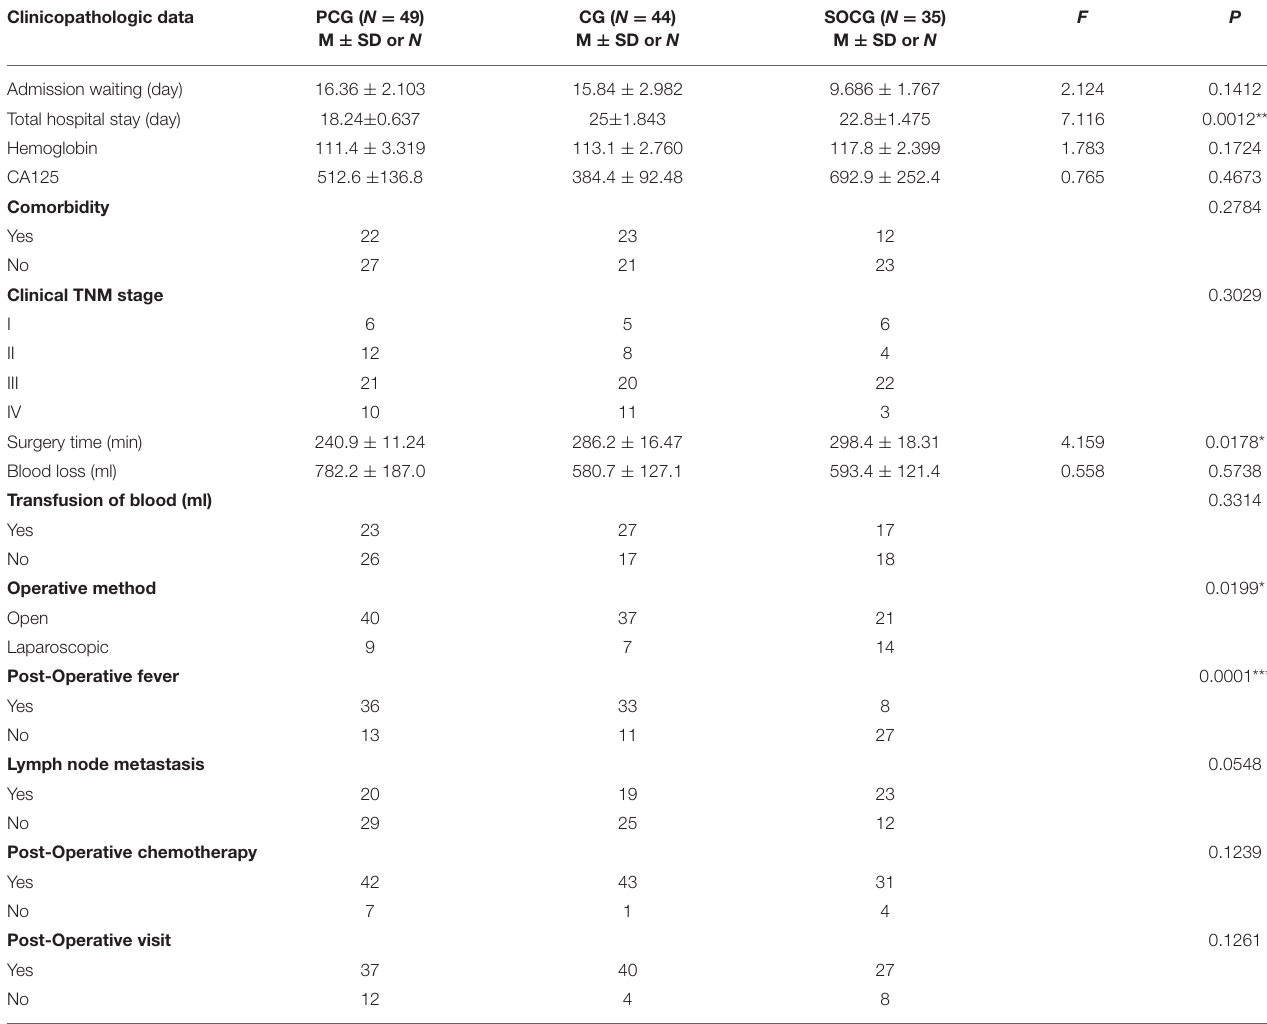
TABLE 2 | Clinicopathological data of all patients enrolled. Clinicopathologic